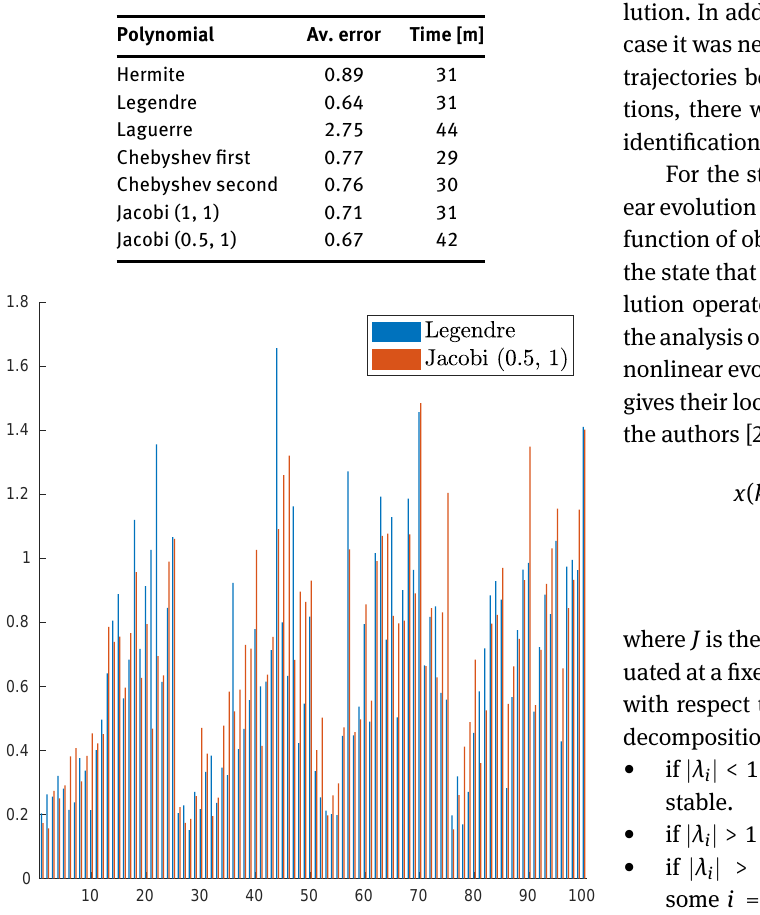
Table 4: Grid optimization results for different types of polynomials.